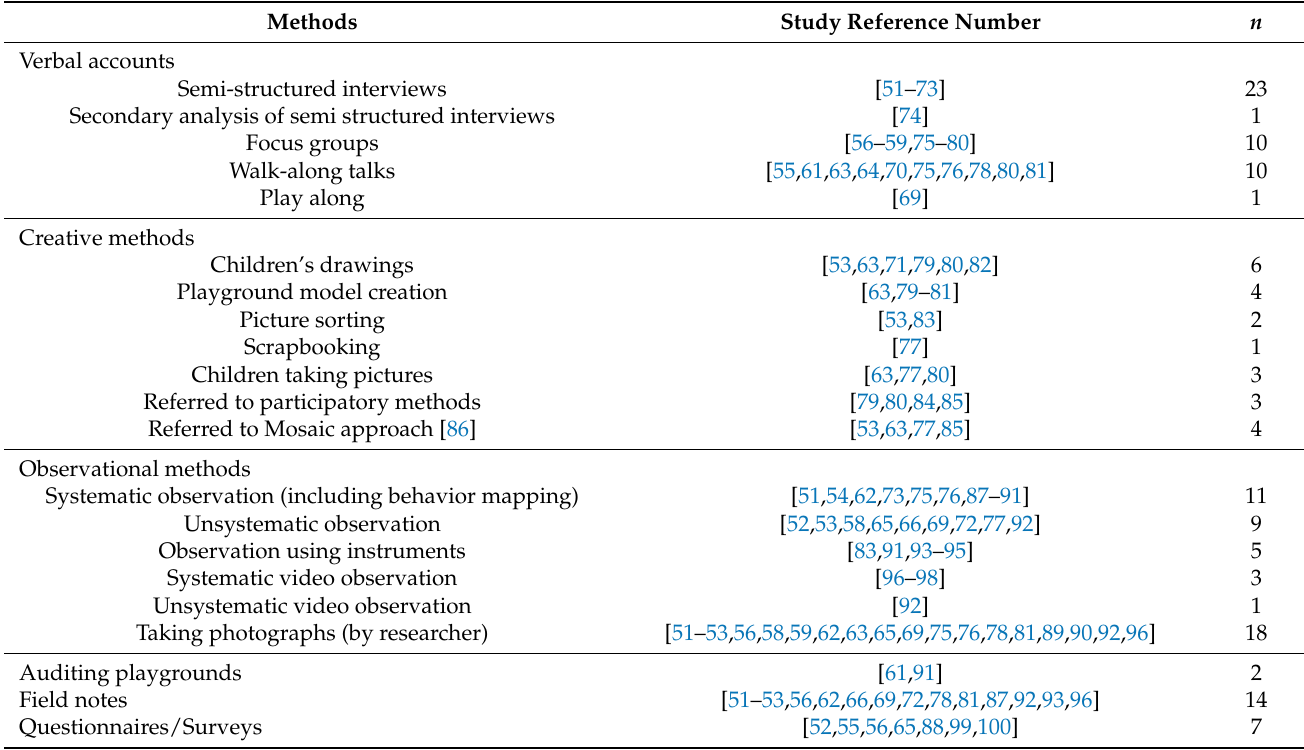
Table 3. Data collection methods of the included